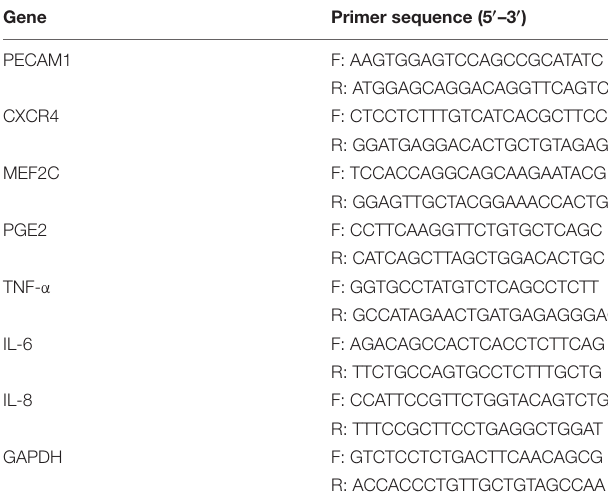
TABLE 1 | Primer sequences for RT-qPCR. Gene